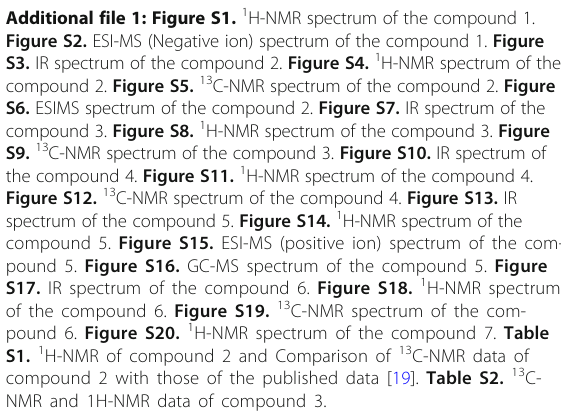
Additional file 1: Figure S1. 1 H-NMR spectrum of the compound 1. Figure S2. ESI-MS (Negative ion) spectrum of the compound 1. Figure S3. IR spectrum of the compound 2. Figure S4. 1 H-NMR spectrum of the compound 2. Figure S5. 13 C-NMR spectrum of the compound 2. Figure S6. ESIMS spectrum of the compound 2. Figure S7. IR spectrum of the compound 3. Figure S8. 1 H-NMR spectrum of the compound 3. Figure S9. 13 C-NMR spectrum of the compound 3. Figure S10. IR spectrum of the compound 4. Figure S11. 1 H-NMR spectrum of the compound 4. Figure S12. 13 C-NMR spectrum of the compound 4. Figure S13. IR spectrum of the compound 5. Figure S14. 1 H-NMR spectrum of the compound 5. Figure S15. ESI-MS (positive ion) spectrum of the com- pound 5. Figure S16. GC-MS spectrum of the compound 5. Figure S17. IR spectrum of the compound 6. Figure S18. 1 H-NMR spectrum of the compound 6. Figure S19. 13 C-NMR spectrum of the com- pound 6. Figure S20. 1 H-NMR spectrum of the compound 7. Table S1. 1 H-NMR of compound 2 and Comparison of 13 C-NMR data of compound 2 with those of the published data [19]. Table S2. 13 C- NMR and 1H-NMR data of compound